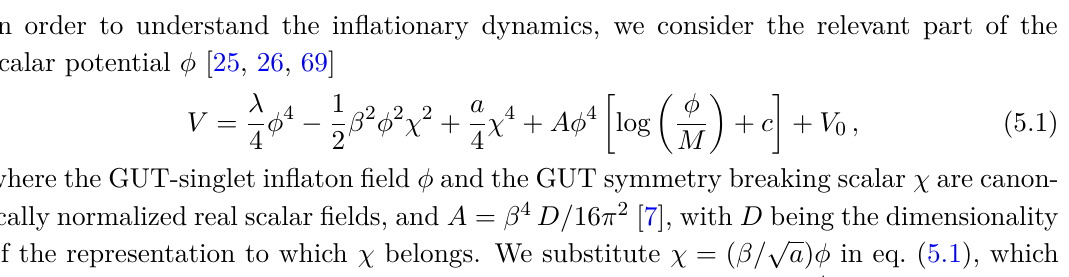
(a) Contour plot of M . (b) Contour plot of τ X Figure 3. Contour plots for the SO(10) breaking chain in section 3.1, where the symmetry breaking at M is achieved by the VEV of (1 , − 1 / 2 , 1 , 1) ⊂ 16 . For this fit, we G 2 → G 2 II L 1 R 3 C 1 B − L L 1 Y 3 C have g [0 . 52 , 0 . 53] , r ∈ [0 , 1] , and g ∈ [0 . 40 , 0 . 60] U ∈